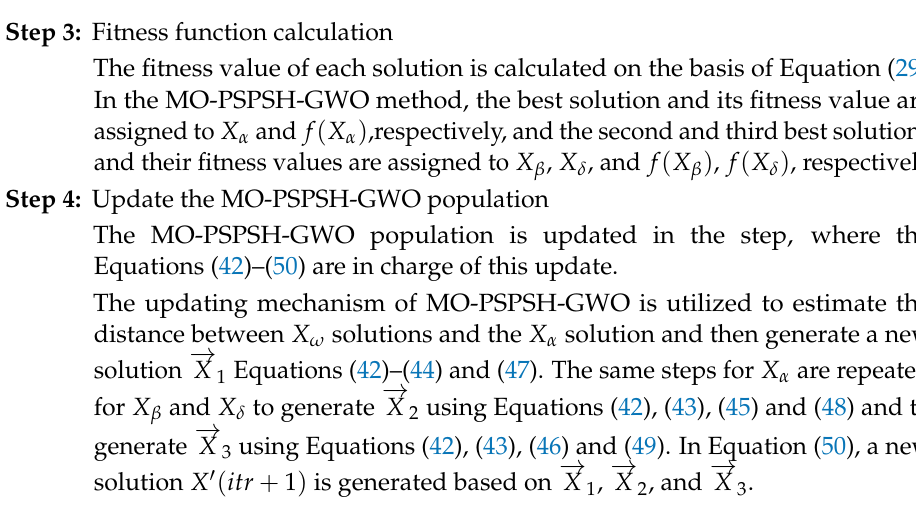
Figure 5. Solution representation for MO-PSPSH-GWO